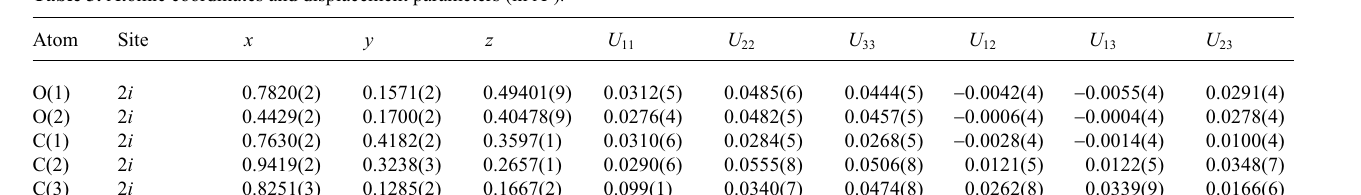
Table 3. Atomic coordinates and displacement parameters (in Å 2 ) .